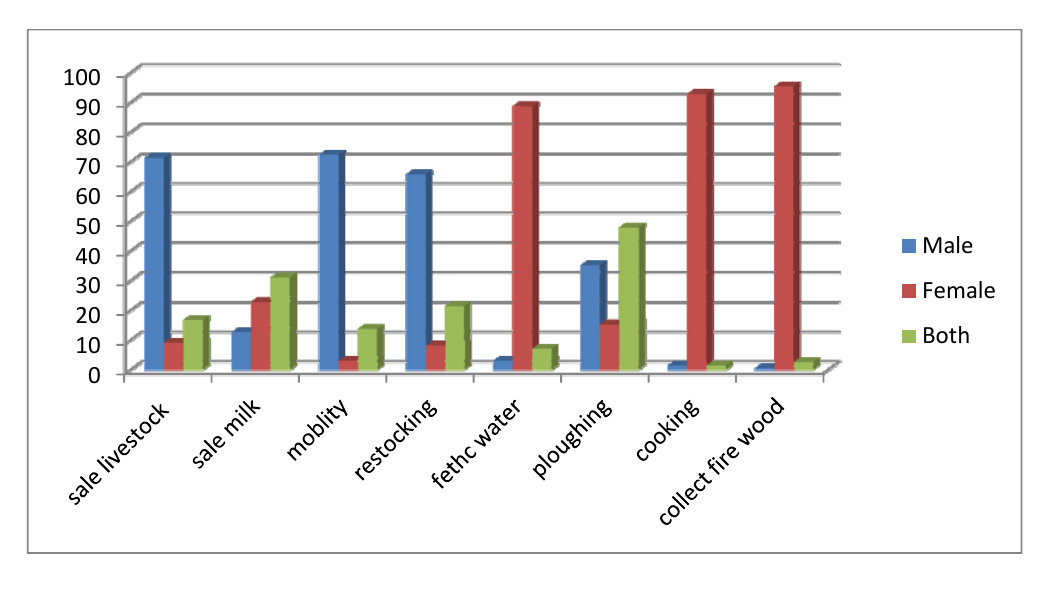
Figure 2. The role of men and women in livestock production.